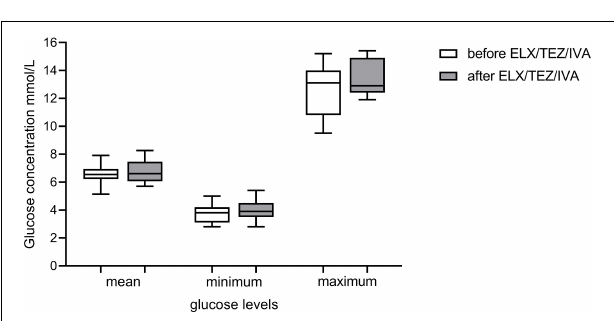
FIGURE 5 | Glucose levels of continuous glucose monitoring (CGM) prior and after initiation of ELX/TEZ/IVA therapy in people with cystic fibrosis. Mean, minimum and maximum glucose levels (mmol/l) of CGM measurements prior (measurements of 2 days) and after (measurements of 5 days) starting ELX/TEZ/IVA therapy. Displayed are boxplots with medium and interquartile range.